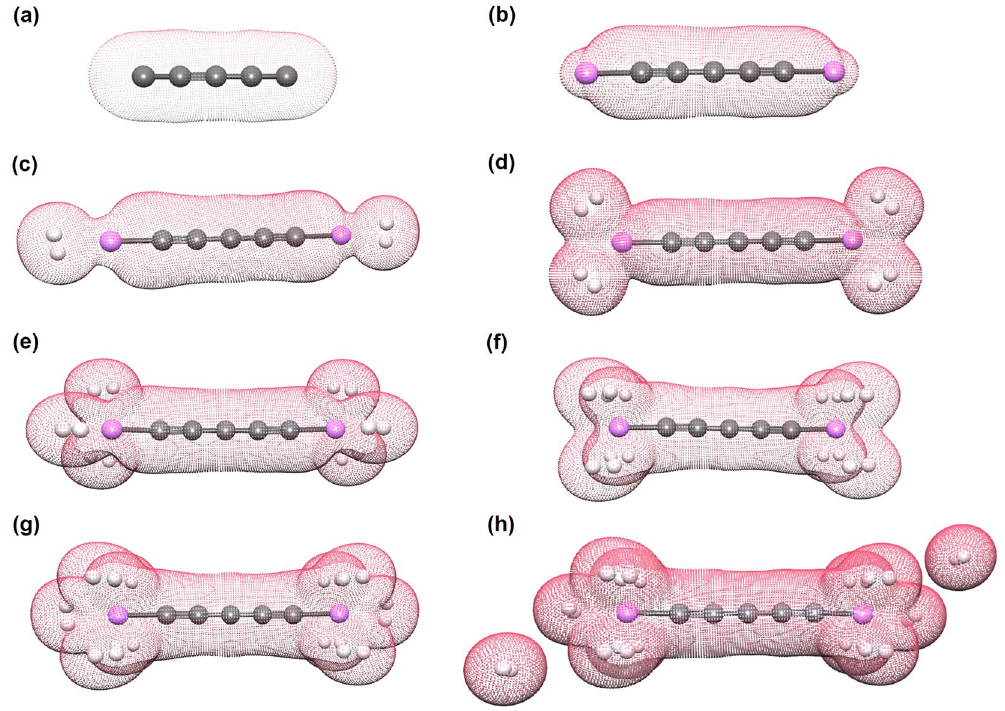
Figure 9. Charge density isosurfaces of ( a ) C 5 and ( b – h ) Li 2 C 5 with x H 2 molecules ( x = 0–6) adsorbed on each Li atom, calculated using TAO-BLYP-D, at isovalue = 0.02 e/Å 3 . Here, grey, white, and purple balls represent C, H, and Li atoms,